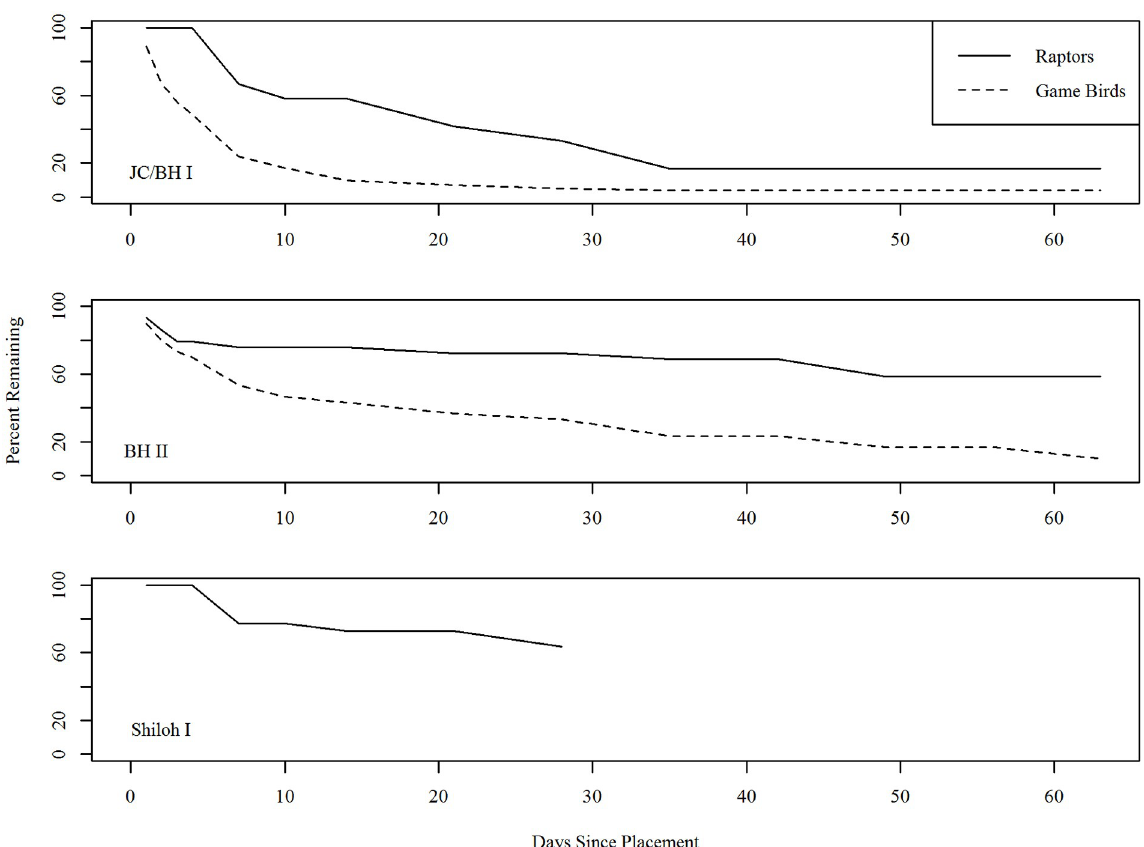
Fig 7. Empirical carcass persistence for raptors and game birds, by